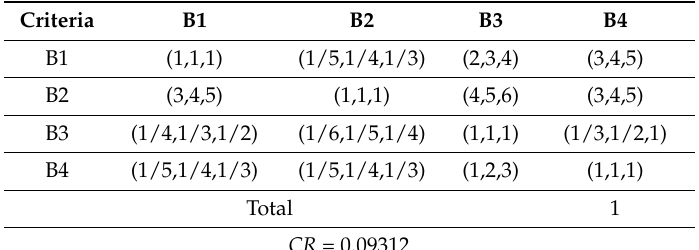
Table 7. Comparison matrix for B.